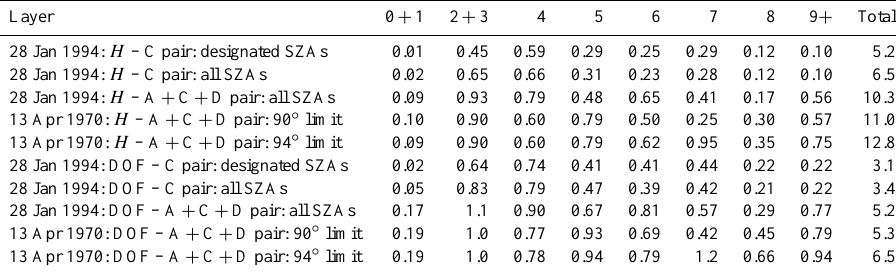
Table 2. Retrieval information content and degrees of freedom.